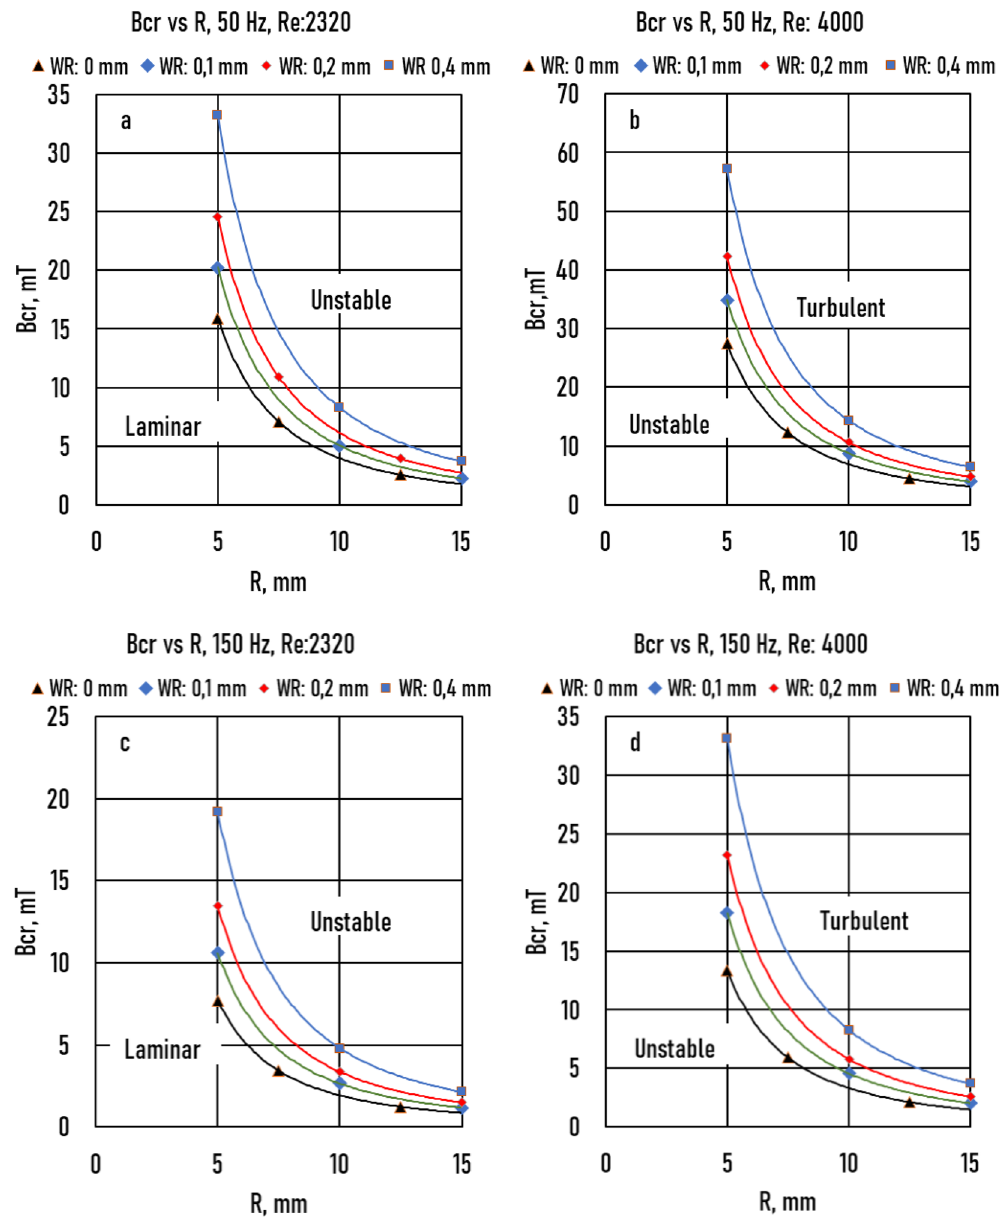
Figure 14. Effect of Wall Roughness ( WR ) on the critical magnetic induction ( Bcr ) ( a ): f = 50 Hz, Re = 2320; ( b ): f = 150 Hz, Re = 4000; ( c ): f = 150 Hz, Re = 2320; ( d ): f = 150 Hz, Re =